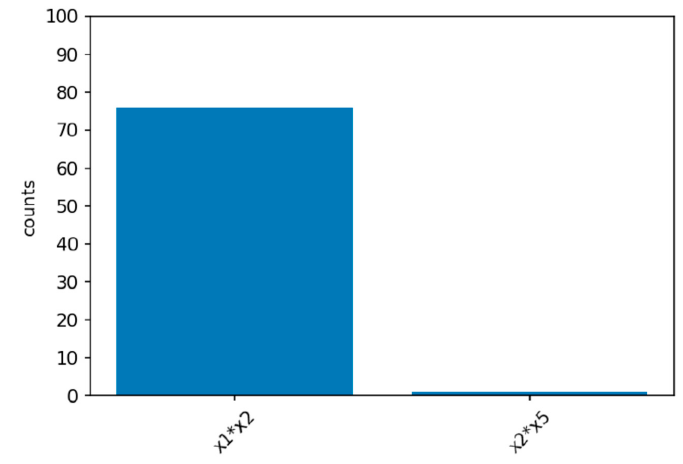
Figure 5. Power simulation under the moderate interaction effect of normal (1, 1) for XGB-FI.